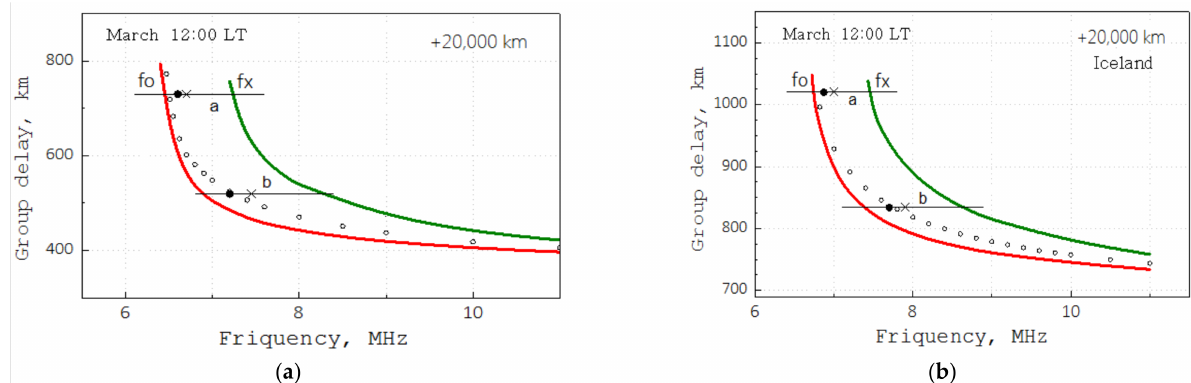
Figure 5. Synthesized transionograms with the magnetoionic tracks at local noon on the paths from the fixed-height satellite to the receiving point, Dickson: in the meridional plane ( a ), and in the latitudinal one, ( b ). The virtual points for the isotropic representation of the refractive index in radio waves propagation are marked by empty